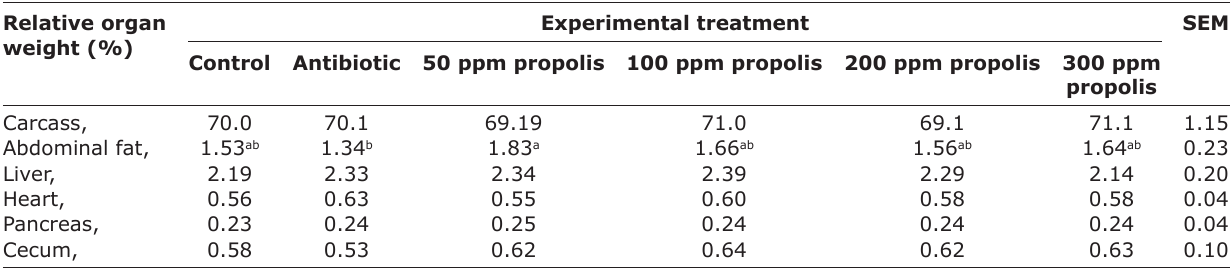
Experimental treatment